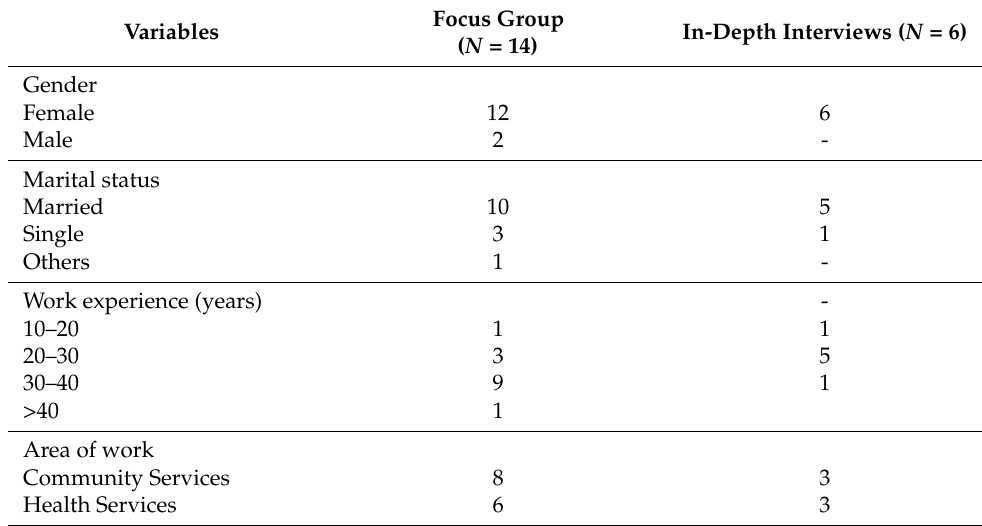
Table 1. Sociodemographic characteristics of